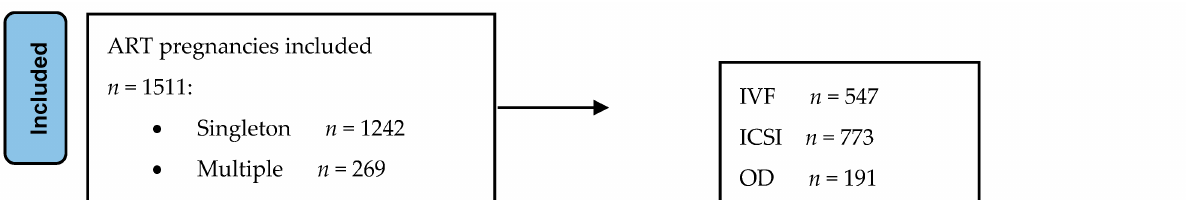
Figure 1. Flow chart of ART cases. ART—assisted reproductive technology (ART); IVF—in vitro fertilization; ICSI—intra- cytoplasmic sperm injection; OD—oocyte donation. Table 1. The characteristics of study population of ART pregnancies.